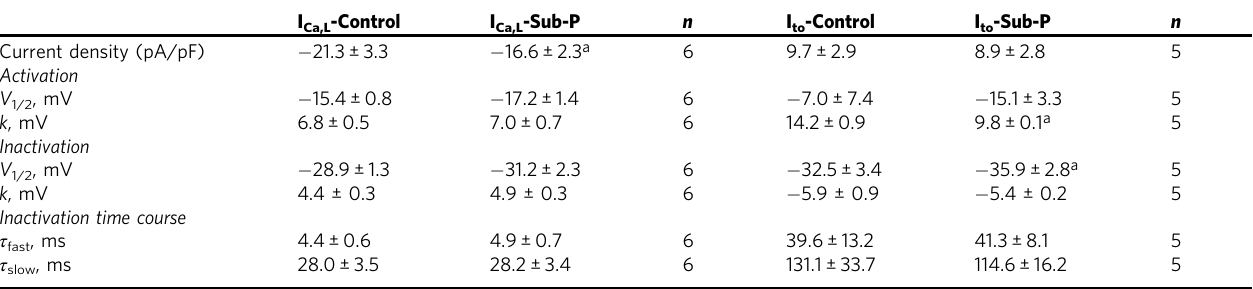
Table 2 Effects of substance-P (10 µ M) on biophysical properties of the L-type calcium current (I Ca,L ) and the transient outward current (I to ) I Ca,L -Control I Ca,L